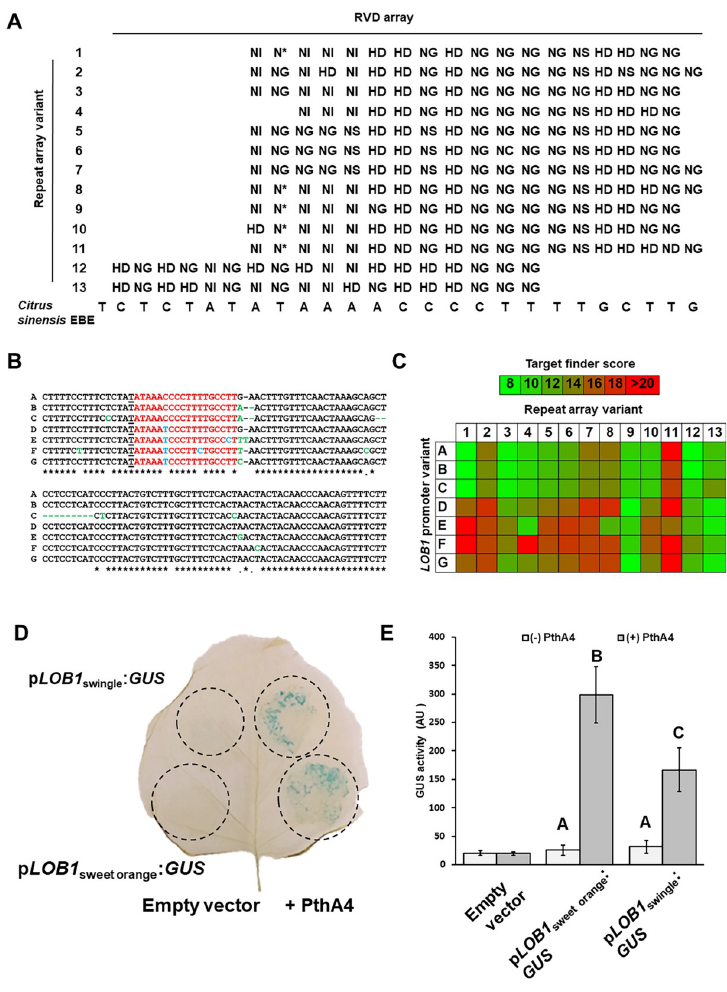
Fig 1. Variability of X . citri LOB1 targeting TALEs and the LOB1 EBE region in Rutaceae species. A. RVD repeat arrays of LOB1 targeting TALEs from X . citri species (Sources are elaborated in Table 1). B. Sequence alignment of allelic variants (Sources are elaborated in Table 2) of the surrounding region of the TALE effector-binding elements (EBEs) from Rutaceae plants. Sequence alignment was conducted with Clustal Omega Multiple Sequence Alignment feature (https://www.ebi.ac.uk/Tools/msa/clustalo/) using default settings. Conserved residues in EBE region are marked in red. Variations in the EBE compared to allelic variant A are marked in blue. Variations in the area outside of the EBE compared to allelic variant A are marked in green. Thymidine residues proceeding EBEs are underlined. C. Target finding scores (lower scores indicate higher predicted binding affinity) of LOB1 targeting TALEs against allelic variants of Rutaceae LOB1 promoter according to TAL Effector Nucleotide Targeter 2.0 using Target Finder tool (https://tale-nt.cac.cornell.edu/). Scores are depicted in colored heat maps correlating to the ruler placed on the top of the table. D and E. Induced expression of sweet orange and Swingle citrumelo LOB1 by PthA4. Nicotiana benthamiana leaves were inoculated with Agrobacterium to co-express His-PthA4 or an empty vector with GUS reporter under the control of the LOB1 promoter from sweet orange ( Citrus sinensis ) or Swingle citrumelo ( Poncirus trifoliata x Citrus paradisi ). Expression of His-PthA4 was driven by an estradiol-inducible system and 17 β -estradiol was applied at 24 h after agro-infiltration. D. Histochemical GUS staining of inoculated leave at 72 h after 17 β -estradiol treatment. Experiment was repeated three times with similar results. E. GUS activity (arbitrary units [AU]) in inoculated areas was determined at 72 h after 17 β -estradiol treatment. Values are means ± SE of nine biological replicates. The experiment was conducted three times and each experiment was composed of three biological replicates. Letters denote significant differences based on analysis of variance (Anova) and comparisons for all pairs using Student’s t -test ( P -value < 0.05).